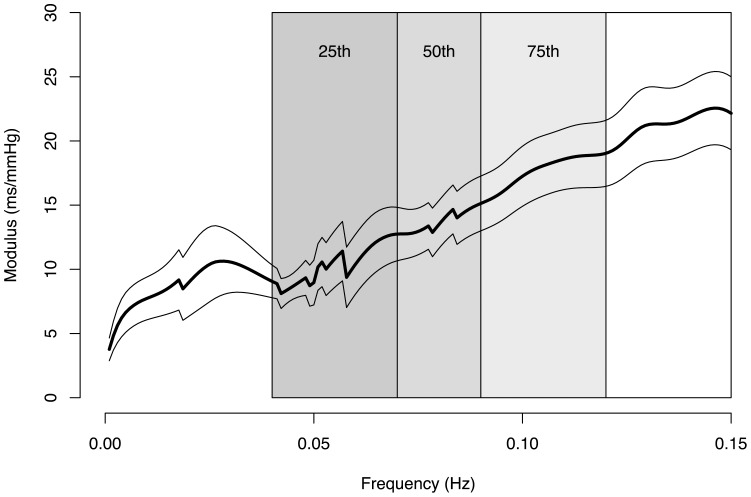
Transfer function modulus curve in the low-frequency region averaged for all subjects.Thick line displays average values, thin lines display standard deviation of transfer function modulus. Shaded areas represent the segments calculated according to the 25th, 50th and 75th percentiles of the transfer function modulus (see Methods).